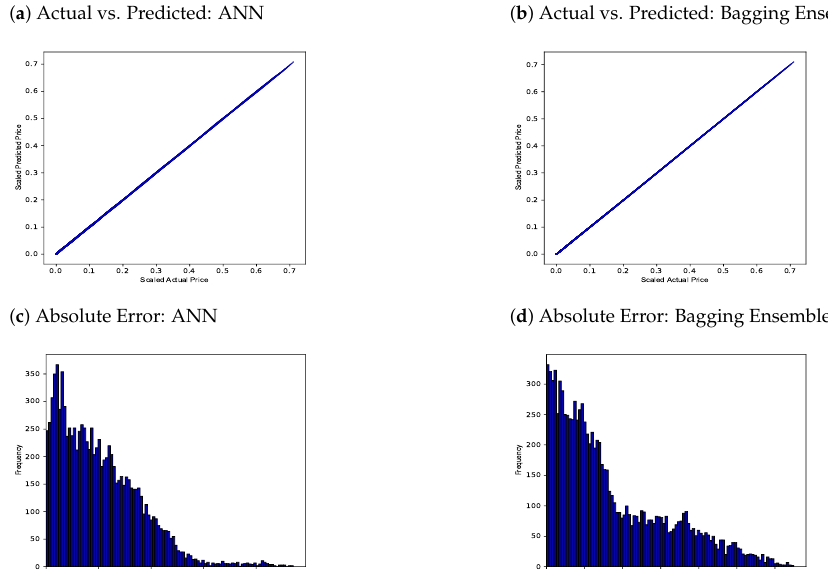
Figure 11. Actual vs. Predicted Results: Fully Collateralised